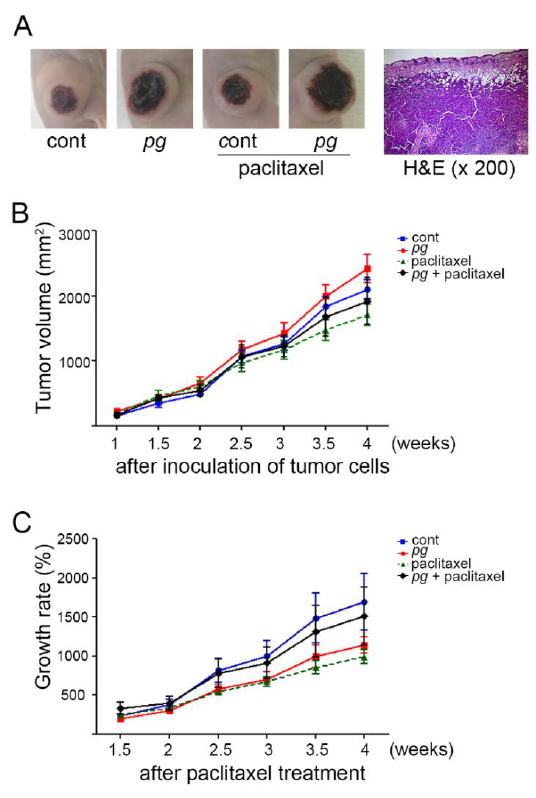
Figure 1. Comparisons of the tumor volume and growth rate between P. gingivalis -treated and / or paclitaxel-treated mice. ( A ) Photographs of OSCC xenografts in mice and representative images of H & E-stained sections of tumor masses ( × 200 magnification). Tumor volumes ( B ) were measured twice per week after the subcutaneous implantation of tumor cells, and the growth rate of the tumor masses ( C ) was calculated. Data are presented as the mean ± standard